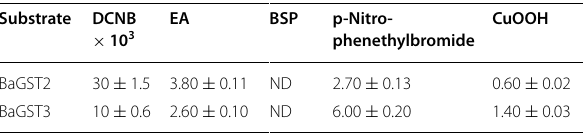
ND no detected activity. Values are means